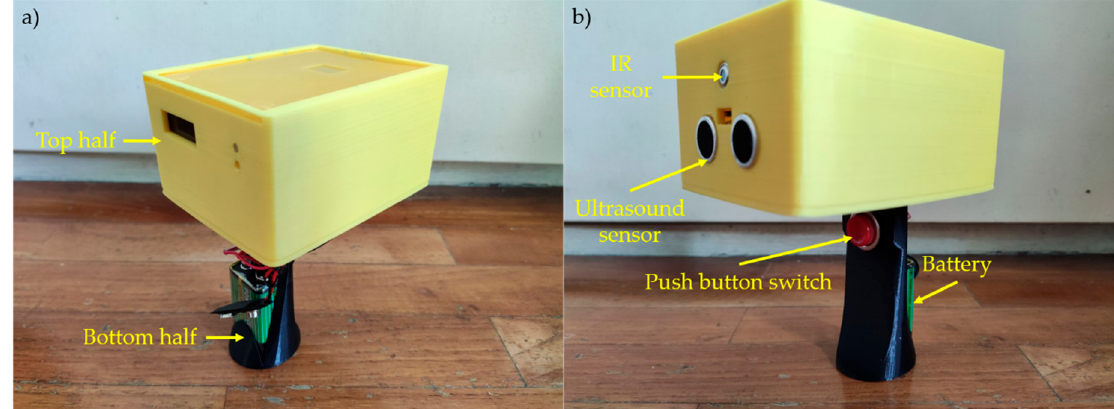
Figure 1. ( a ) Back view of prototype segmented into the top (yellow) and bottom (black) half with color differentiation for display purposes. ( b ) Front view of prototype displaying the IR sensor and ultrasound sensor in the top half. The bottom half of the device includes the push button switch and battery holder.